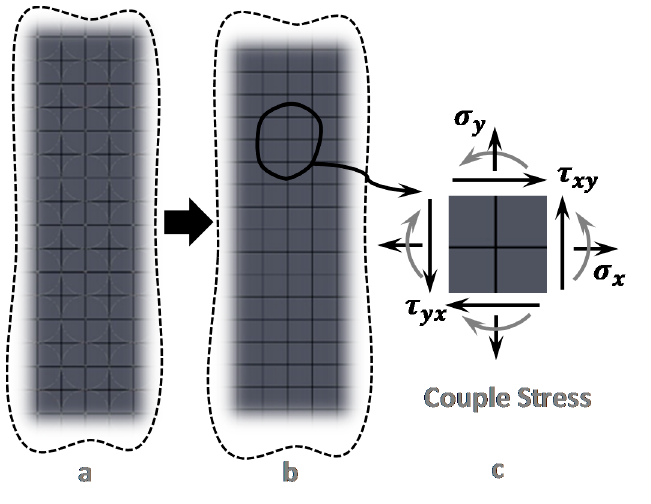
Figure 2. Schematic of the microstructure that justifies Couple Stress Theory (CST). Simple lattice model of heterogeneous materials illustrating dependency of material behavior on couple stress; ( a ) Microstructure of a heterogeneous elastic material; ( b ) Equivalent Lattice Model; ( c ) Normal and shear stresses on a typical in-plane element in presence of the couples